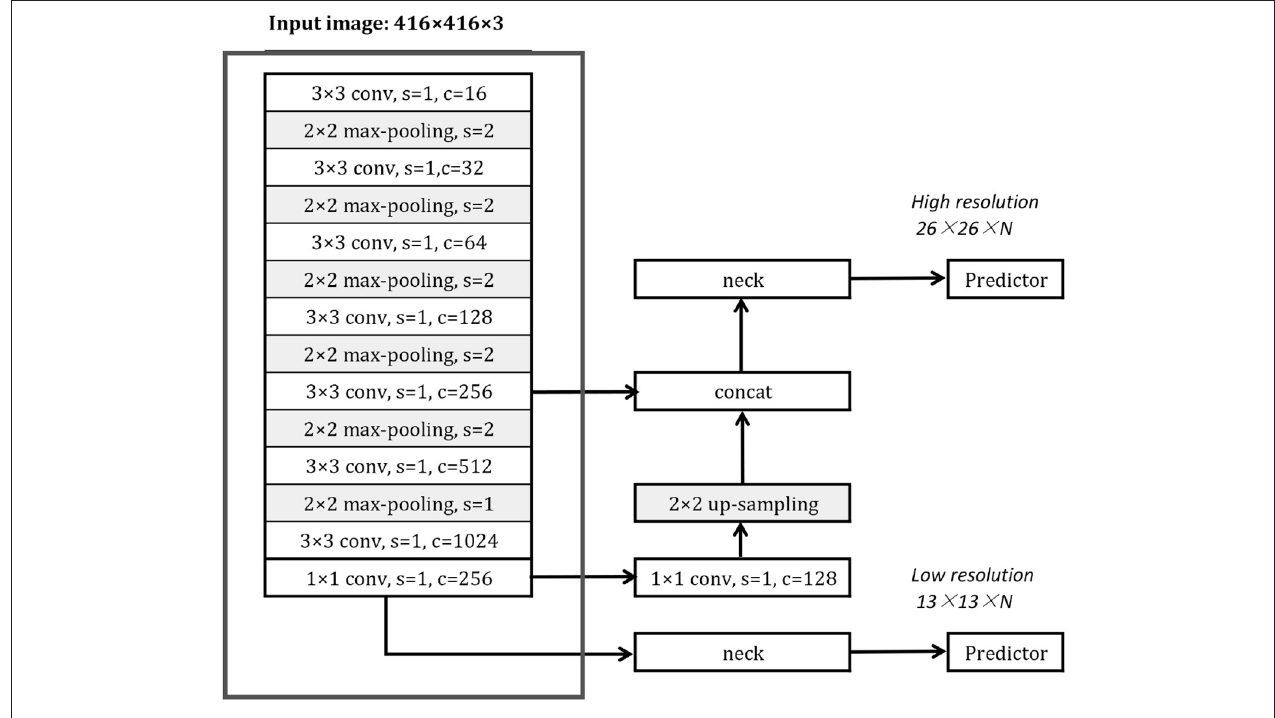
FIGURE 4 | The YOLOv3-Tiny framework, s: stride, c: channel.